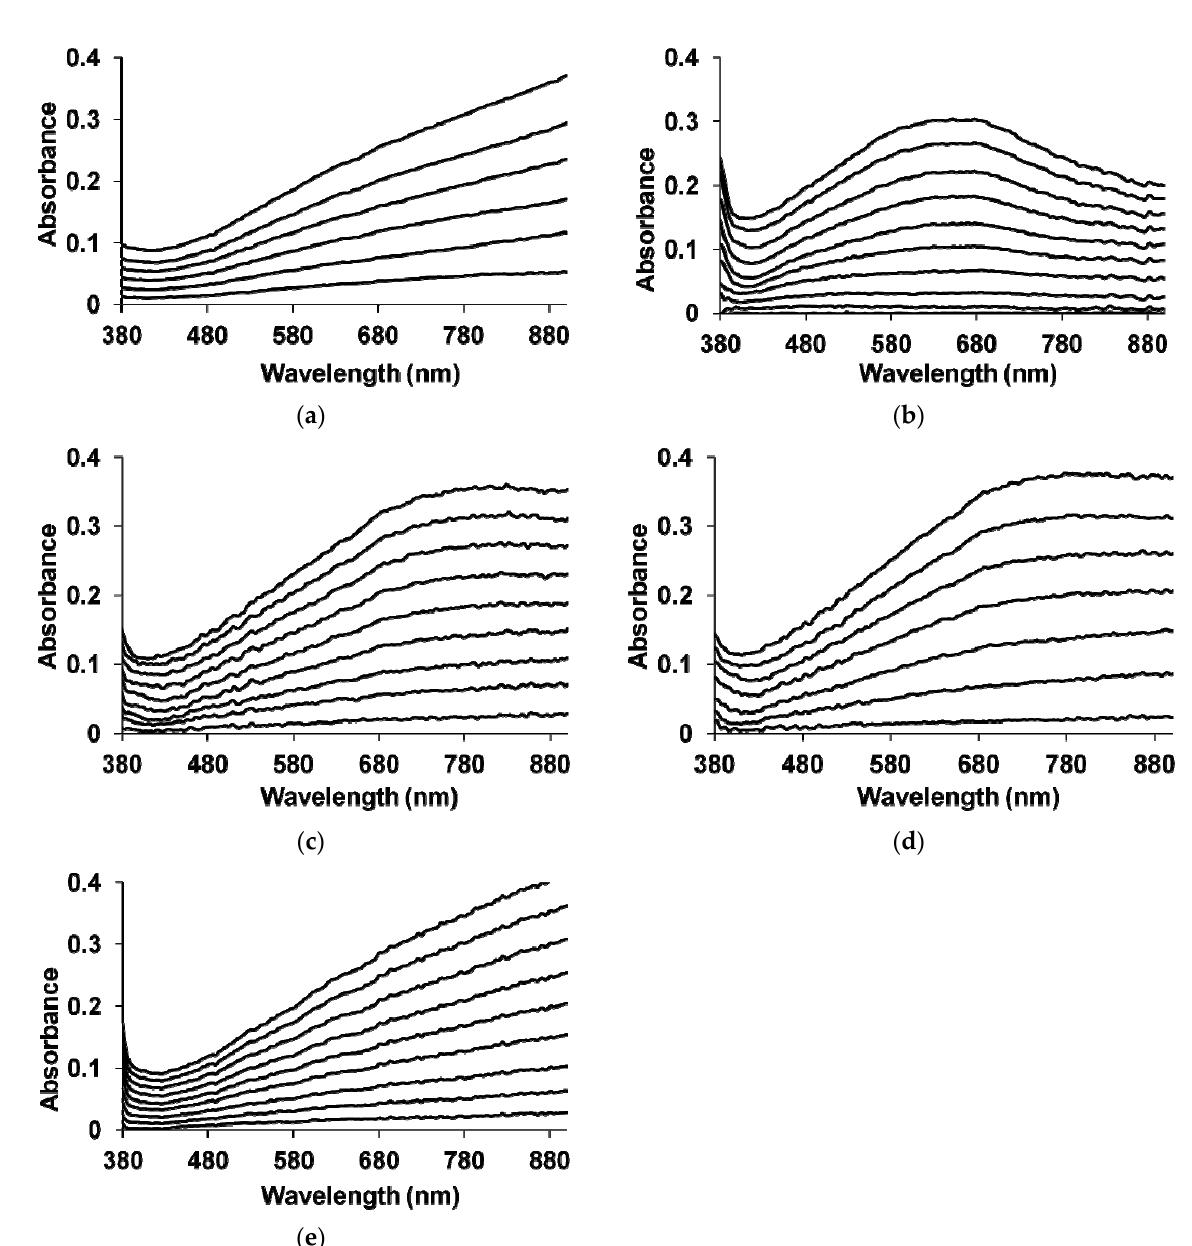
Figure 4. Electronic UV–Vis absorption spectra of PEDOT films formed on the working electrode during GS synthesis in aqueous solutions of PAMPSA ( a ), t-PASA ( b ), PAMPSA/t-PASA (1:1) ( c ), PAMPSA/t-PASA (2:1) ( d ) and PAMPSNa/t-PASNa ( e ).